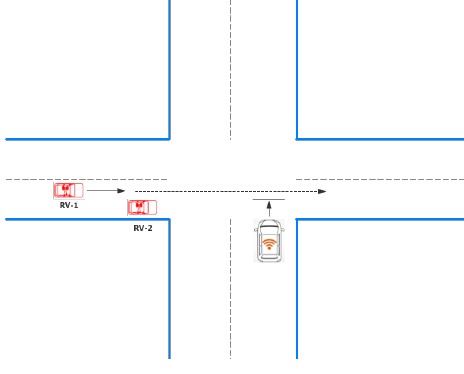
Figure 2. HV starts at the intersection.